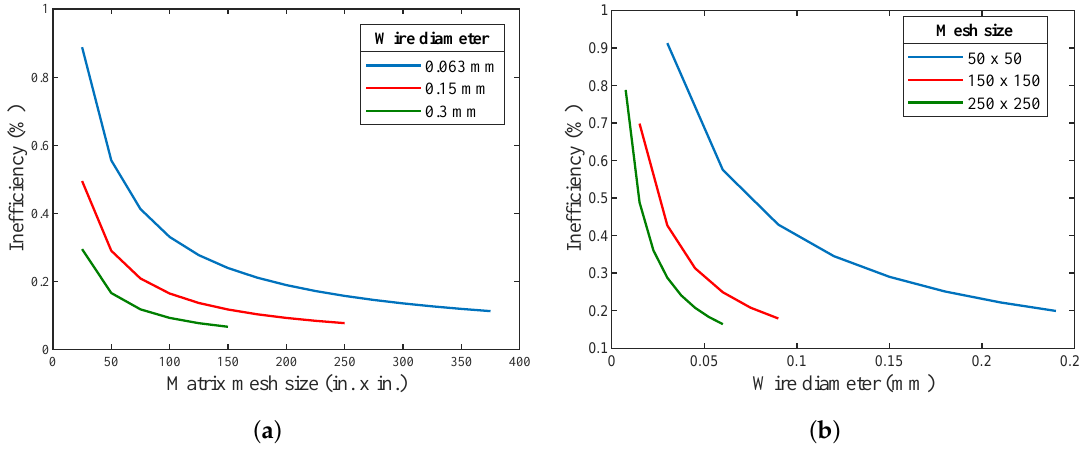
Figure 8. ( a ) The relation between the matrix mesh size and Ie. ( b ) The relation between the mesh wire diameter and Ie for several mesh sizes (for a regenerator of 7.5 mm diameter and 30 mm length).